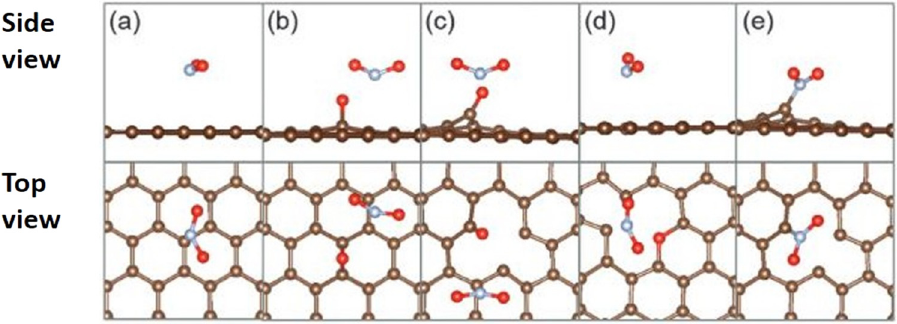
Figure 9: Optimized structure of the NH 3 molecule adsorbed on ( a ) pristine graphene, ( b ) sp 3 - type defect ( epoxy group )- graphene, ( c ) sp 3 - type defect ( carbonyl group )- graphene, ( d ) sp 3 - type defect ( ether group )- graphene, and ( e ) single vacancy of graphene. The red, brown, grey, and light pink colours represent O, C, N, and H atoms, respectively. Reproduced from ref. [ 105 ] .